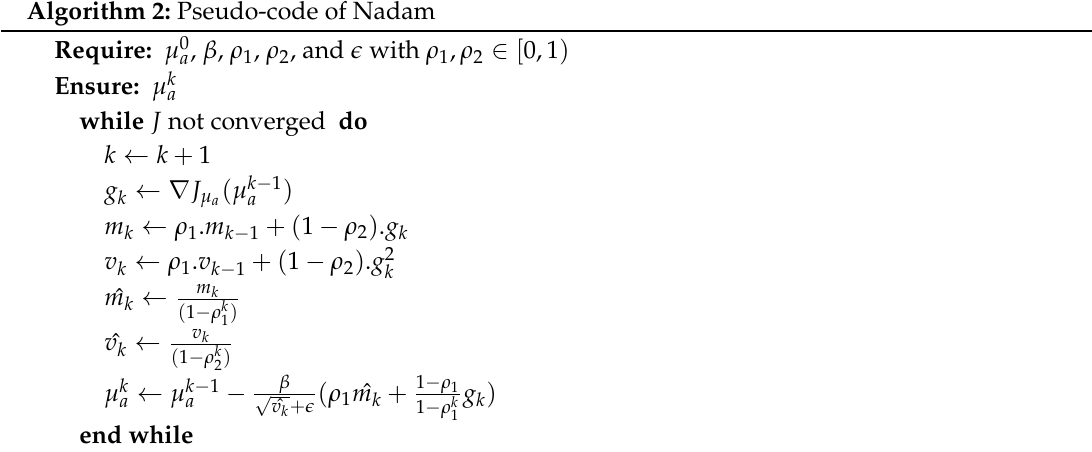
Algorithm 2: Pseudo-code of